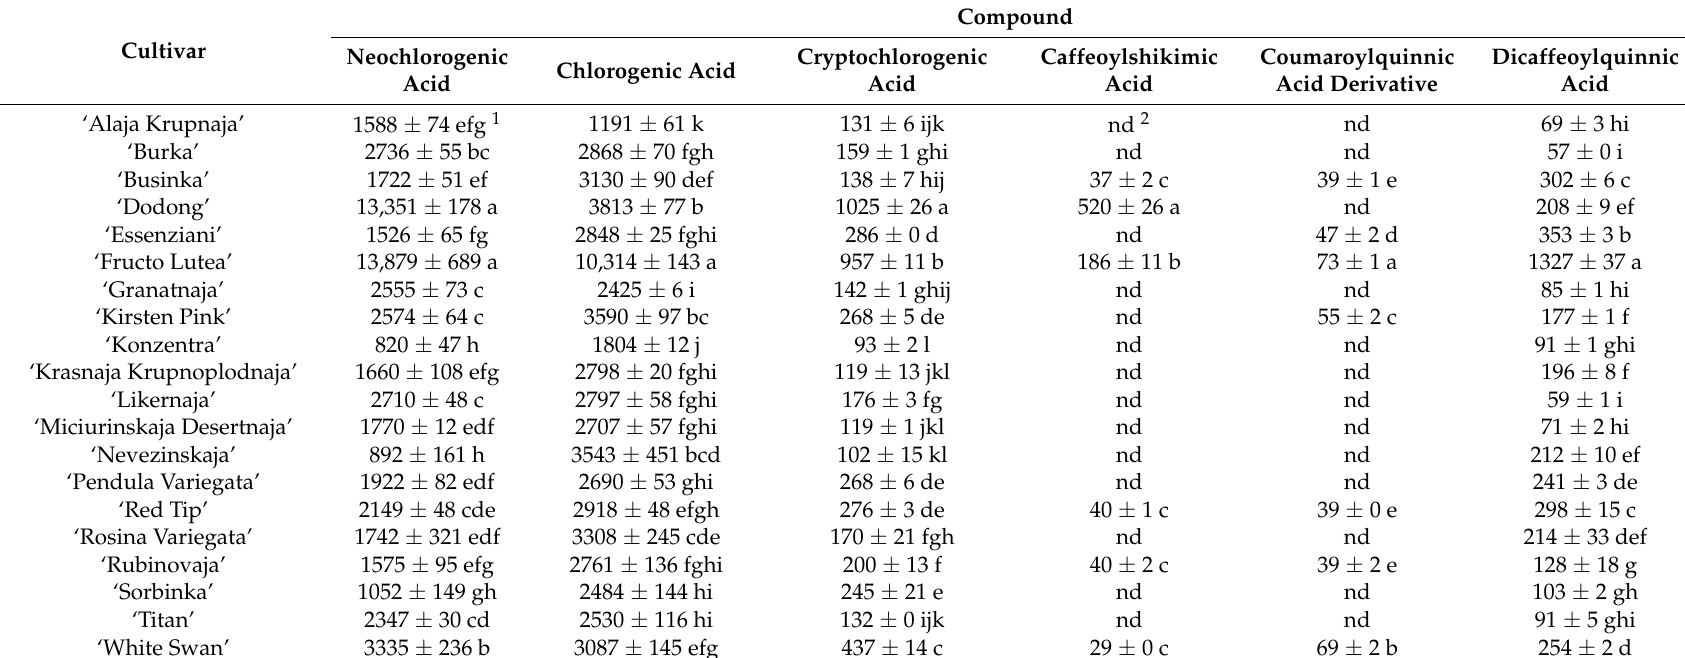
Table 1. Contents of phenolic acids ( µ g/g DW) in Sorbus fruit powder